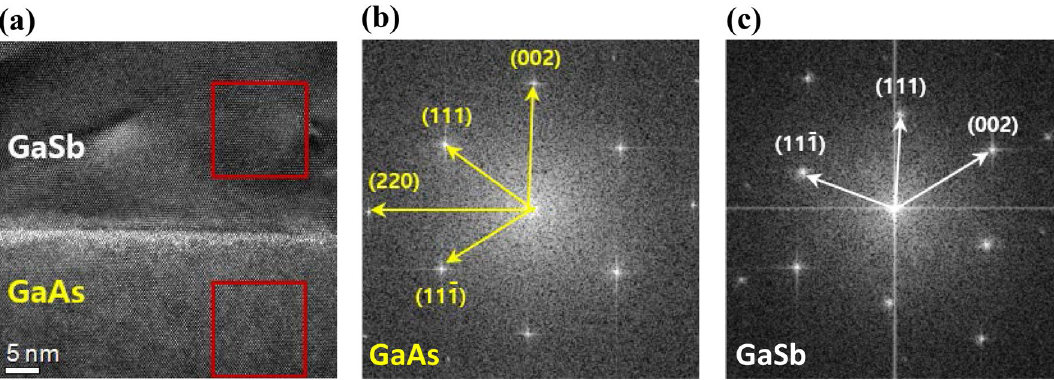
Figure 3. ( a ) Cross-sectional TEM images of the GaSb QD and GaAs layer, and selected-area diffraction patterns of ( b ) GaAs layer and ( c ) GaSb QD for confirming change of growth direction in GaSb film surface containing the QD and the Sb layer, with a root mean square roughness (R q ) of ~ 3 nm. Second, SEM and TEM were used to confirm the shape, distribution density, and diameter of the QDs. From the SEM and TEM data shown in Fig. 2b,c, an average diameter of 100 ± 5 nm was obtained for the QD. Focusing on the zone axis in the [111] direction, it was found that the nanostructure of the GaSb QD was neither spherical nor pyramidal; rather, the QD had a nanowire-like pillar shape with a zinc-blende structure. The density of the QDs was less than 10 μm −2 , as shown in Fig. 2b,c. Furthermore, considering Fig. 2c and Supporting Figure S2, the GaSb nanostructure was formed via the self-catalyzed nanowire formation mechanism 5 , rather than the Stran- ski–Krastanov growth mechanism 17–20 . Specifically, the Ga droplet was formed in 10.6 s, equal to the deposition time of the 5-ML GaAs, as shown in Supporting Figure S2. Subsequently, a 40-nm-thick Sb layer was deposited on the GaAs surface, confirmed by the cross-sectional energy-dispersive X-ray (EDX) analysis of the outside of the QDs, as shown in Supporting Figure S3, where GaSb nanowires were grown under the growth conditions of the diffusion-limited process for the Sb atom. Because the migration of Sb was slow at 180 °C 21 , the amount of Sb that diffused into the Ga droplet was insufficient. In this case, the Ga droplet was used as a self-catalyst for QD growth, similar to nanowire growth. During the growth of the QDs, the wetting-like layer (WLL) observed around the GaSb nanostructure was not attributed to the growth of the GaSb QDs. Most of the Sb is considered to have vaporized during the increase in the substrate temperature up to 280 °C, and the origin of the WLL was attributed to the intermixing of residual Sb around the GaAs layer (see the inset of Figure S3). To further investigate the nanostructure of the samples, we analyzed the cross-sectional TEM images, as shown in Fig. 3a, where a clear difference was observed. The top and bottom areas of the image indicate the GaSb QD and GaAs layer, respectively. Each red square from the bottom to the top shown in Fig. 3a was processed by fast Fourier transform (FFT), as shown in Fig. 3b,c. Based on the FFT images in Fig. 3b,c, the elongated direction of the QDs was not parallel to the [001] direction of the GaAs substrate. The cross-sectional image revealed that the QDs grown along the [111] direction of the GaAs layer had a zinc-blende structure. Using the reciprocal lattice constants of the GaAs layer in each direction, which were 2.93 nm −1 , 2.96 nm −1 , and 3.41 nm −1 from the selected-area diffraction (SAD) pattern, the diffracted plane was indexed based on the reported data, as shown in Fig. 3b 22–24 . Moreover, using the reciprocal lattice constants of GaSb in each direction, which were 2.60 nm −1 , 2.71 nm −1 , and 3.17 nm −1 , the diffracted plane was indexed, as shown in Fig. 3c. Based on the reported lattice constants of (111), (11-1), and (002), we indexed the plane of the reciprocal lattice following the length of each direction, as shown in Fig. 3c. By comparison with the reported lattice constant of GaSb 25, 26 , we confirmed that the difference in the lattice constant of GaSb QDs was ~ 1.8%. From this result, we suggest that owing to the high lattice mismatch between GaAs and GaSb (> 7%), the growth direction of the GaSb QDs was changed to reduce the strain, allowing the most stable growth of the QDs. In this process, the strain was reduced by approximately 1.8% along the [111] direction. As a result, we can confirm that the QD is well grown along the [111] direction of GaAs with ~ 1.8% lattice strain. The GaSb QDs were thus successfully grown by a nanowire formation mechanism with a limited amount of group III material. To investigate the band alignment between the GaSb QD and GaAs layers, we performed PL measurements. Figure 4a presents the PL spectra of a QD sample measured at 16 K with laser power of 1–30 mW. Consider- ing the peak separation using Gaussian fitting, the PL peak at 1.05 eV, which had a full width at half maximum (FWHM) of approximately 258 meV, was attributed to the GaSb QDs. The energy of the PL peak emission was somewhat lower than those reported for GaSb QDs in previous papers 16, 27–29 . Three peaks were observed at 1.47 eV, 1.24 eV, and 1.32 eV; the first peak was attributed to bulk GaAs, and the other two peaks were attributed to a GaAs x Sb 1− x WLL. As the laser power density was increased, the peak at 1.05 eV from the GaSb QDs was observed to blue-shift to 1.13 eV. However, the blue shifts of the other two peaks at 1.24 and 1.32 eV from the GaAs x Sb 1− x WLL were weakened, as shown in Fig. 4b. The clear blue-shift behavior with increasing laser power at 1.05 eV was caused by the QD structure; it originated from coulombic interactions and the QD state-filling of holes from the spatial separation of holes in the GaSb QD from the attracted electrons confined in the nearby GaAs regions 16, 30, 31 . However, the peak shifts at 1.24 eV and 1.32 eV showed differences from the nature of QDs. To confirm the GaSb QD properties, we investigated the temperature-dependent PL, as shown in Fig. 4c. Some properties were related to the QD structure of the GaSb embedded in the WLL, as shown in Fig. 4c,d. As